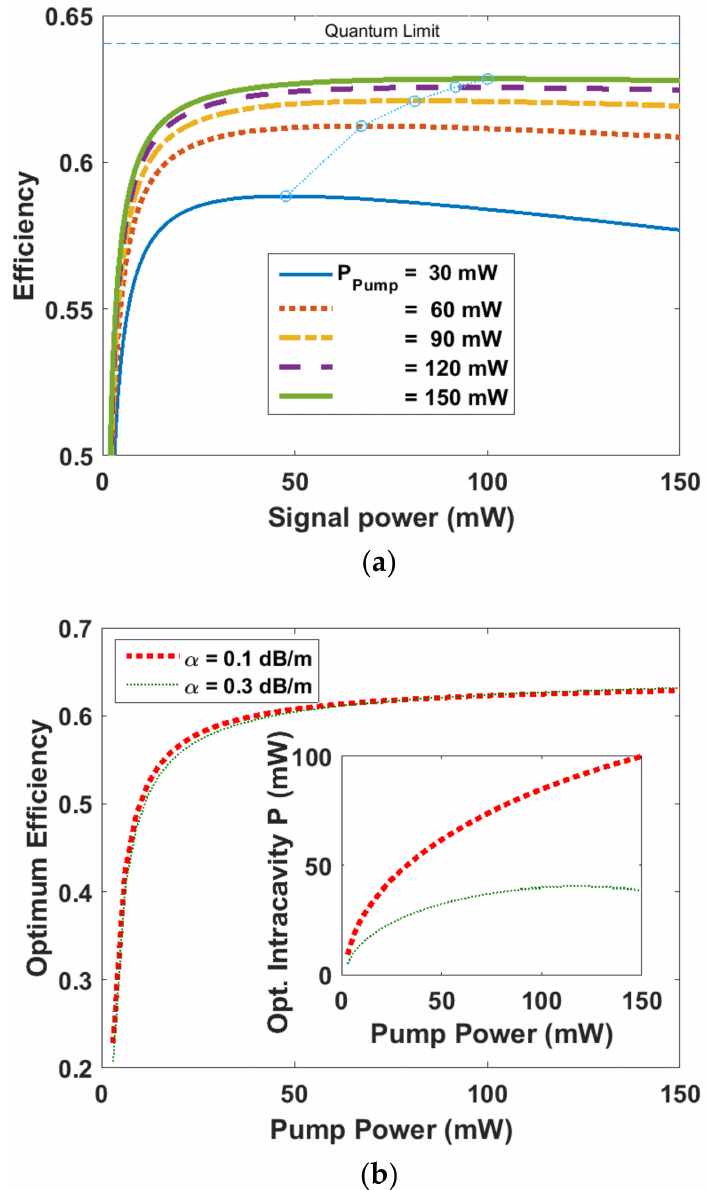
Figure 2. ( a ) Efficiency vs. signal power for various pump powers considering a loss of 0.1 dB/m. Blue dotted line connects the circles representing the maximum efficiencies for each curve. ( b ) Optimum efficiency vs. pump power for two amounts of loss. The inset shows the optimum intra-cavity signal power vs. pump